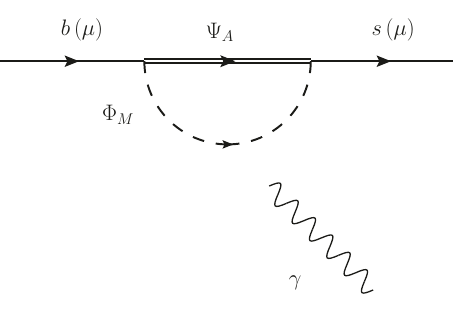
Figure 2 . Photon-penguin diagrams contributing to b ! s(cid:13) transitions and a (cid:22)